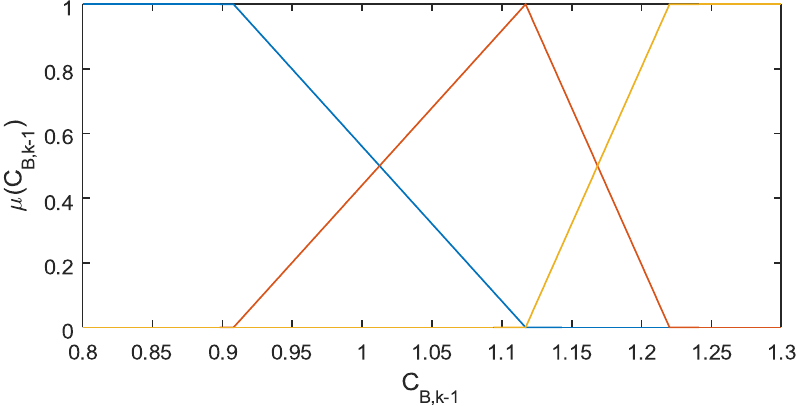
Figure 2. Membership functions of the fuzzy model used to obtain the dynamic